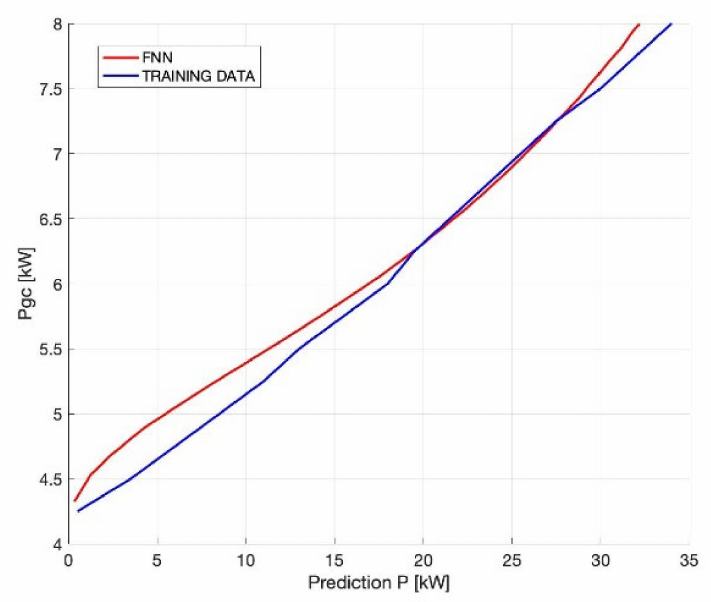
Figure 37. Compilation of the training data with the machine response, scenario 4.